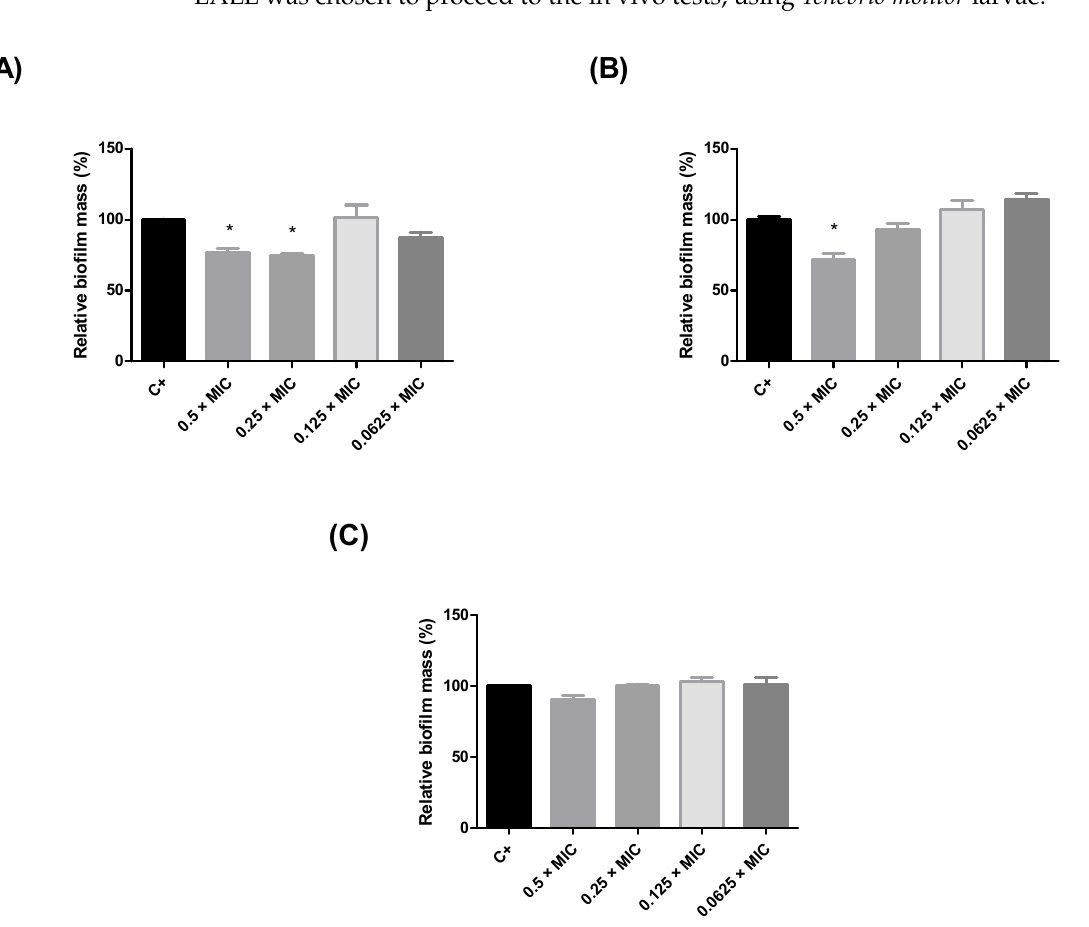
Figure 1. Inhibition of the biofilm formation in Staphylococcus aureus by Humiria balsamifera (Aubl) extracts. ( A ) HLE = hexane leaf extract, ( B ) EALE = ethyl acetate leaf extract, and ( C ) MLE = methanol leaf extract. (*) Significant differences ( p < 0.05) in relation to untreated biofilm (C +).